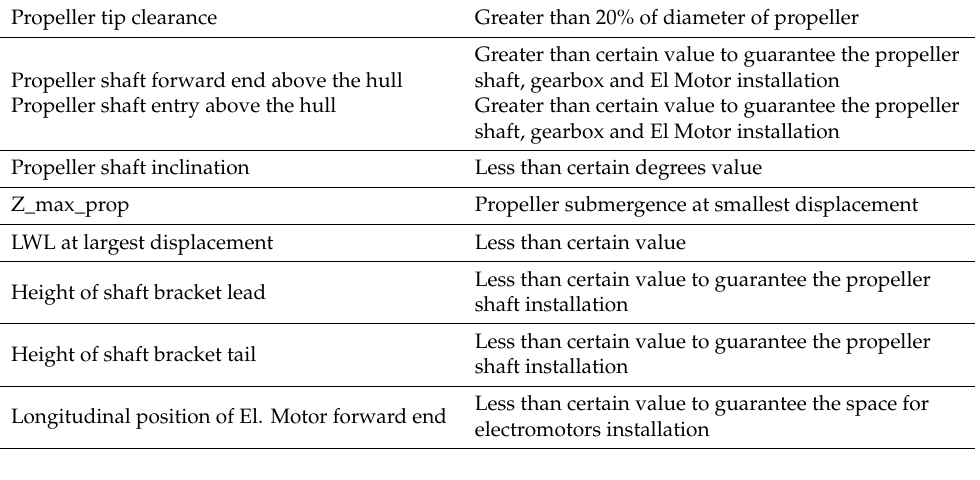
Table 5. Design constraints in local optimization stage.